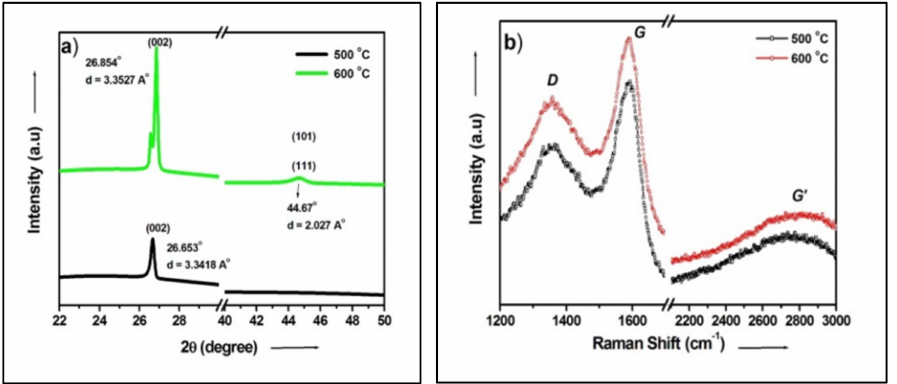
Figure 38. ( a ) XRD and ( b ) Raman spectra of synthesized CNS